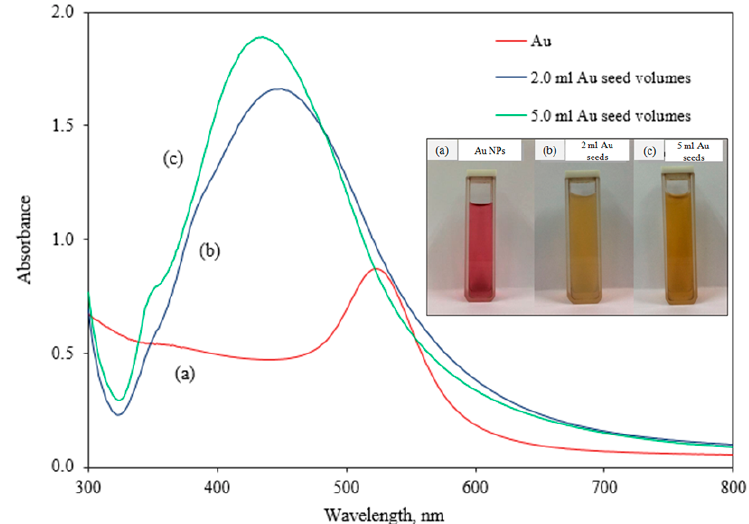
Figure 1. Absorption spectra of ( a ) Au NPs, and Au-Ag bimetallic NPs with ( b ) 2.0 mL and ( c ) 5.0 mL Au seed volumes.